Question: What direction does the quantity move in — increasing or decreasing?
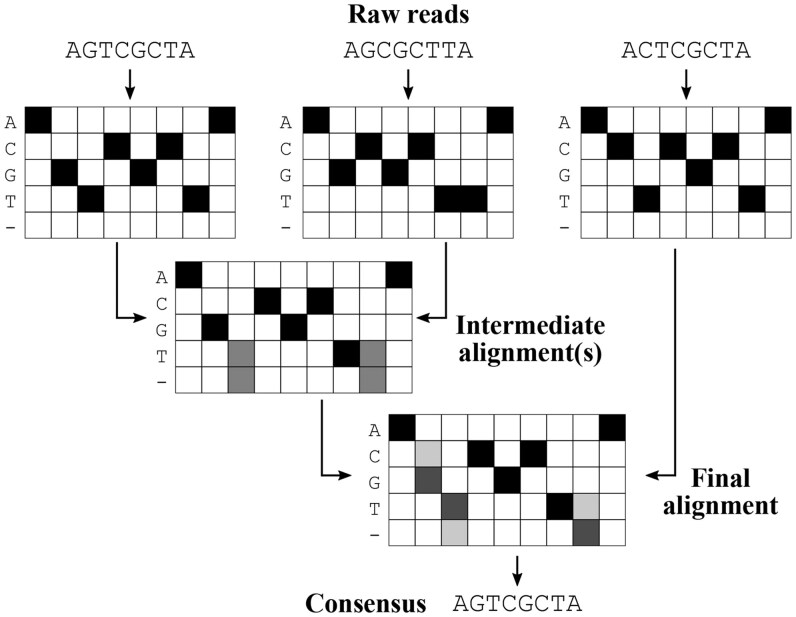
Answer: increasing